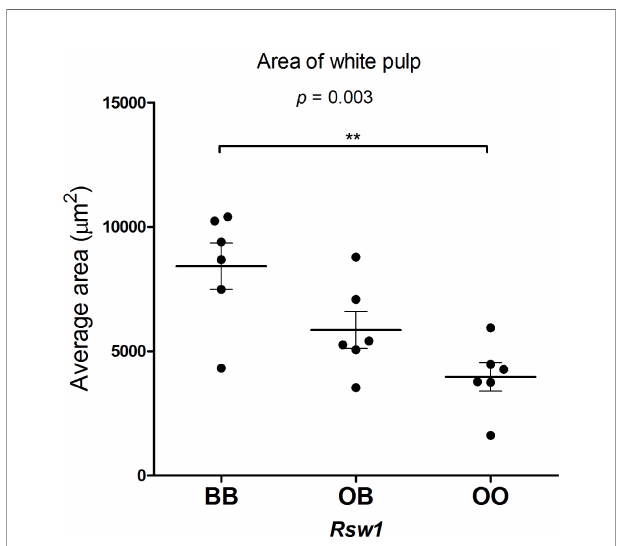
FIGURE 8 | Area of white pulp in F 2 hybrids between B10.O20 and B10. The area of the white pulp was measured using the ellipse formula a*b* p , where “ a ” is the major radius and “ b ” is the minor radius of the white pulp. Each dot represents the average area of 10 white pulps measured three times from each sample. Average age 14 weeks (median 14 weeks, min 13 weeks, max 16 weeks). Statistical analysis was performed by ANOVA, p = 0.0033. Bars represent the average ± SEM. ** p <